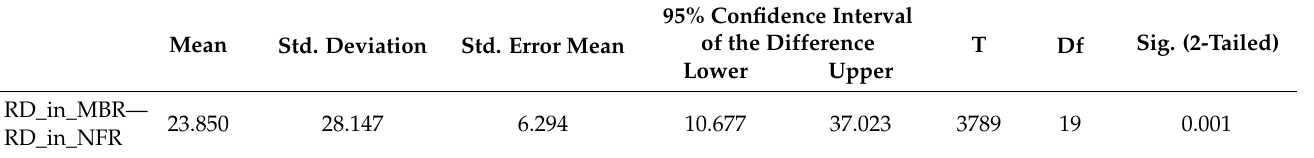
Table 9. Results of